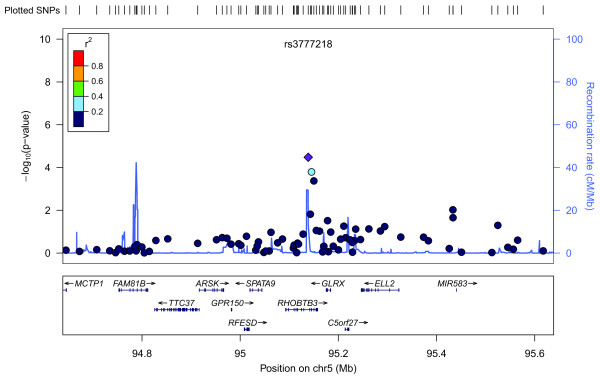
Plot of regional association signals for rs3777218 forwarded for validation.